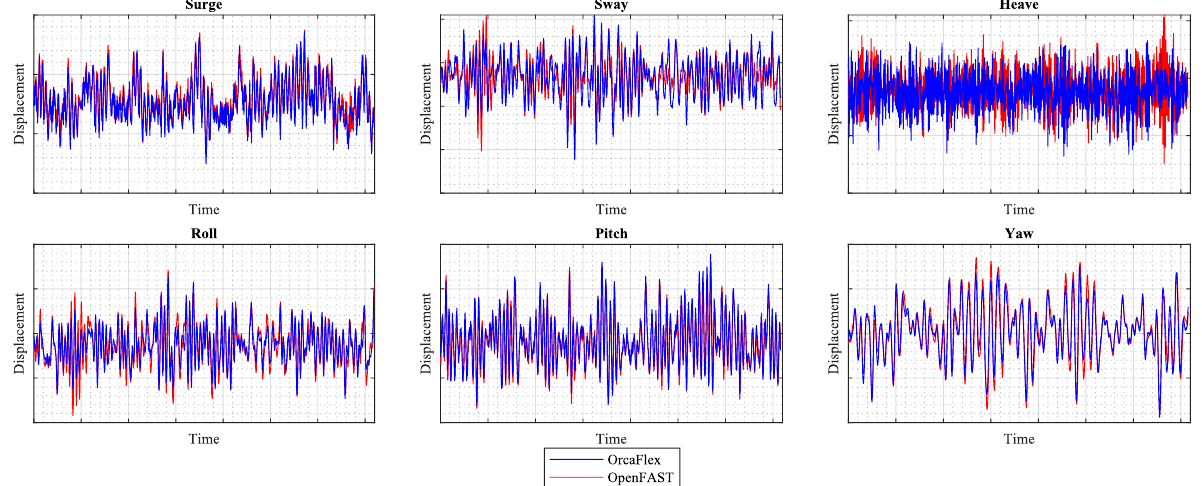
Figure 15. Comparison of six DoF motion of the interface. Note that the irregular sea states are different realizations of the same wave